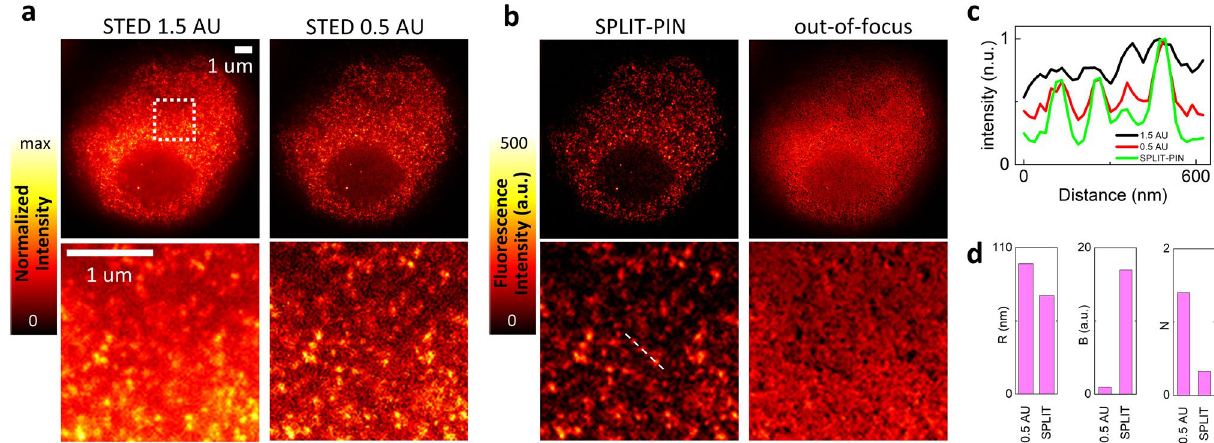
Figure 3. Removal of out-of-focus background in STED microscopy by SPLIT-PIN. ( a ) STED images acquired sequentially at different pinhole size. The images represent transcription foci in fixed U937-PR9 cells. b) SPLIT- PIN image (left) and isolated out-of-focus signal (right). Scale bar 1um. ( c ) Line profile corresponding to the dashed line in ( b ). ( d ) Quantification of Resolution (R), Brightness (B) and Noise (N) parameters for the SPLIT- PIN and 0.5 A.U. images shown in ( a , b ) using the QuICS